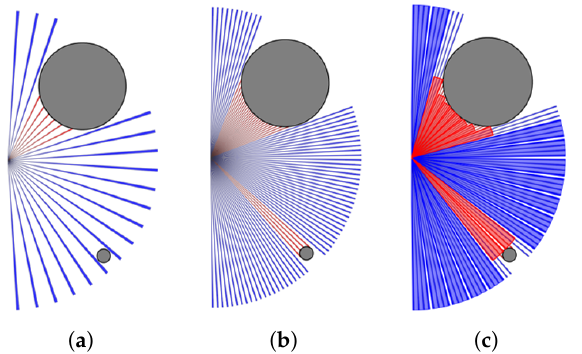
Figure 4. Lidar ranges visualization. Ranges in red mean obstacles are detected. ( a ) Without min pooling, the small object might not be detected with 24 samples. ( b ) The small object can be detected with 96 samples. ( c ) Using min pooling, the small object can be detected with 24